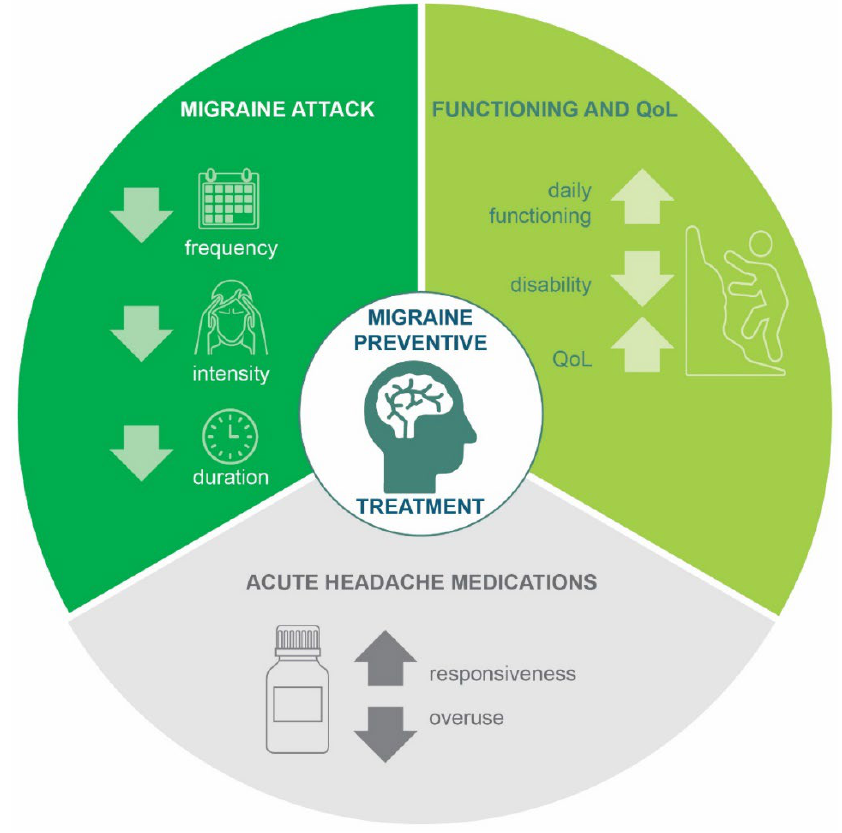
Figure 1. Goals of migraine preventive treatment [2]. QoL, quality of life.